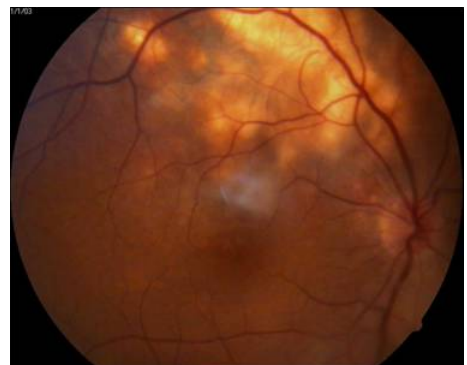
Figure 7: Scarred granuloma seven months after starting anti-tuberculous treatment. Fovea is